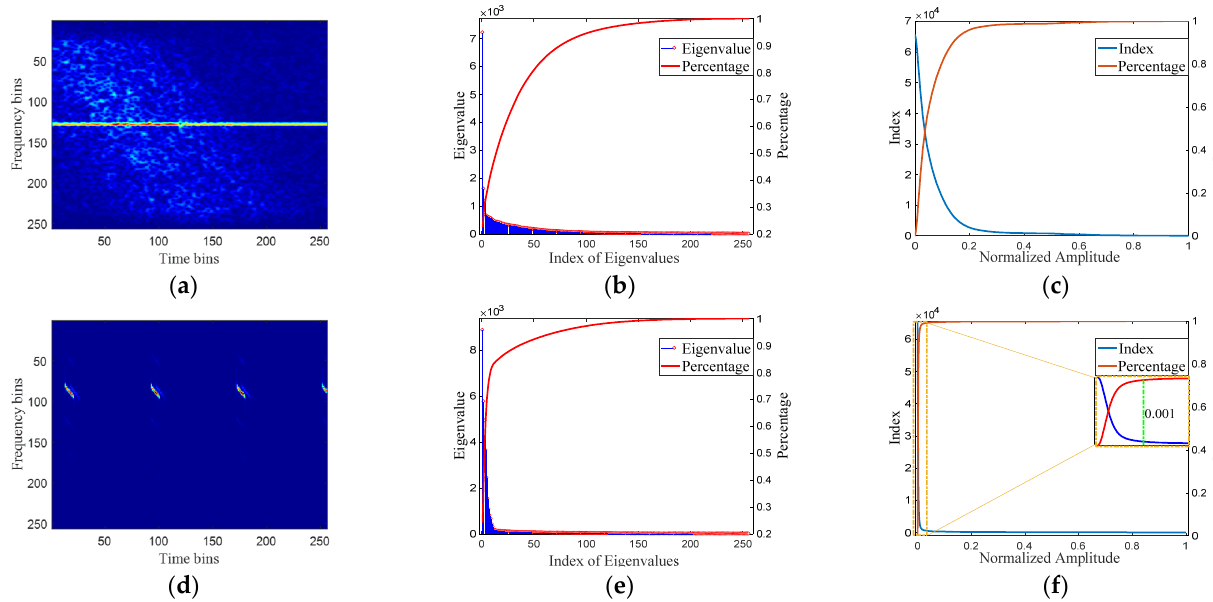
Figure 5. Structural analysis of RFI in the TF domain: ( a , d ), spectrograms of SAR echoes contaminated with NBI and WBI, respectively; ( b , e ), Eigenvalue sequences corresponding to ( a , d ), respectively; ( c , f ), amplitude analyses for ( a , d ), respectively.